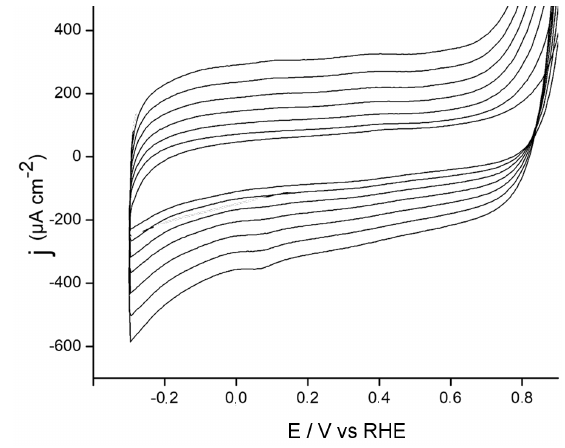
Figure 2. Cyclic voltammetric scans of an SWCNT@SiO 2 electrode in a solution of 3,4 ‐ ethylendioxythiophene (EDOT) in poly (sodium 4 ‐ styrenesulfonate) (PSS). Anodic limit of 1.0 V. Scan rate of 100 mV s − 1